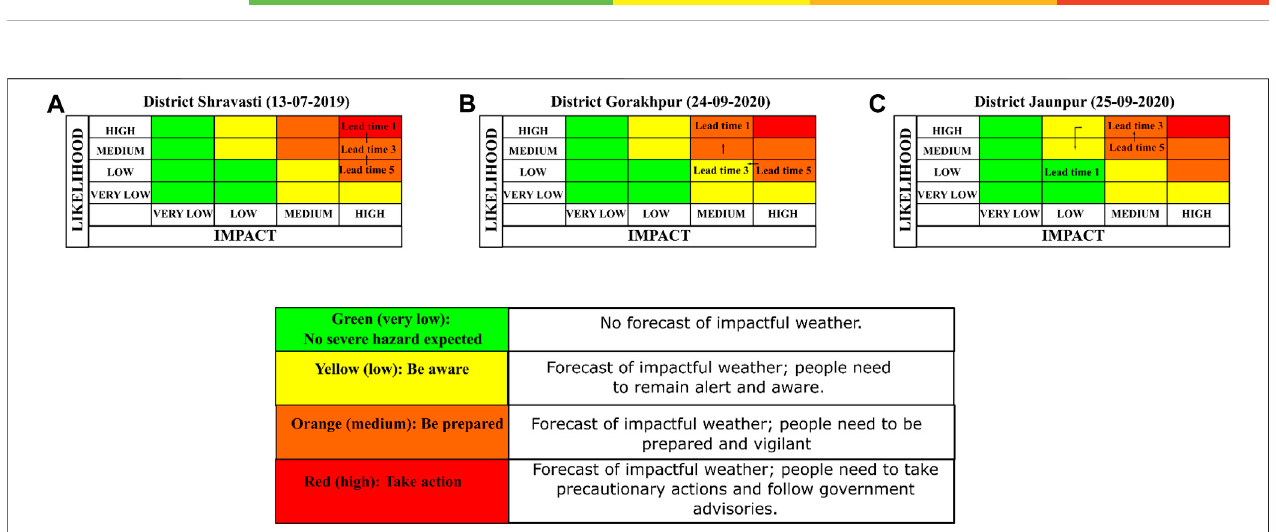
FIGURE7| Samplewarningmatricesfortheselecteddays andtheselecteddistricts basedontherainfall magnitudeofthethreeleadtimes. (A) shows thesample warning matrix for the district Shravasti, (B) shows for the district Gorakhpur while (C) shows it for the district Jaunpur